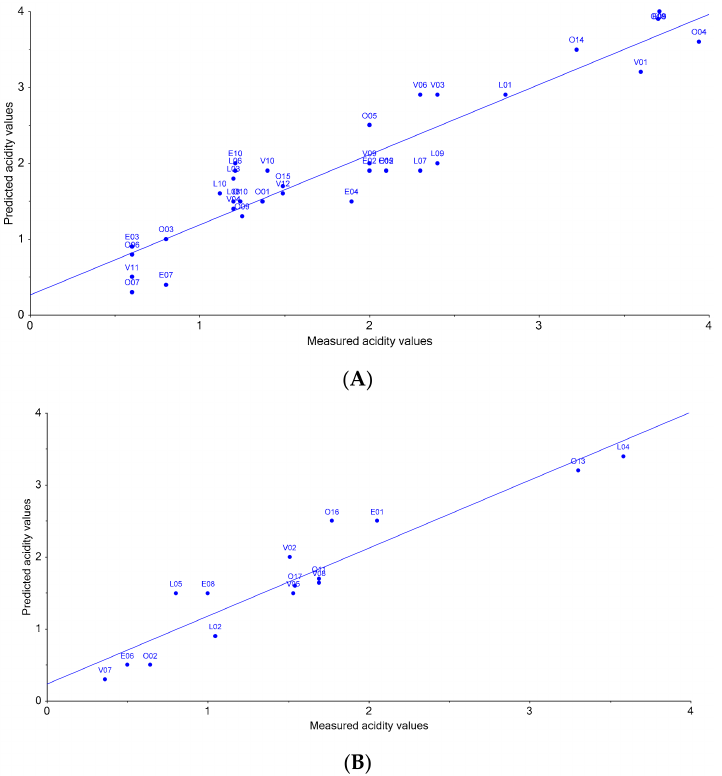
Figure 4. Acidity partial least squares-1 (PLS-1) models using electronic nose (EN) signals (X-matrix) and acidity (Y-matrix) using a test set validation. ( A ) Calibration set (35 samples) and ( B ) validation set (15 samples). E, extra virgin; V, virgin; OV, ordinary virgin; and L,